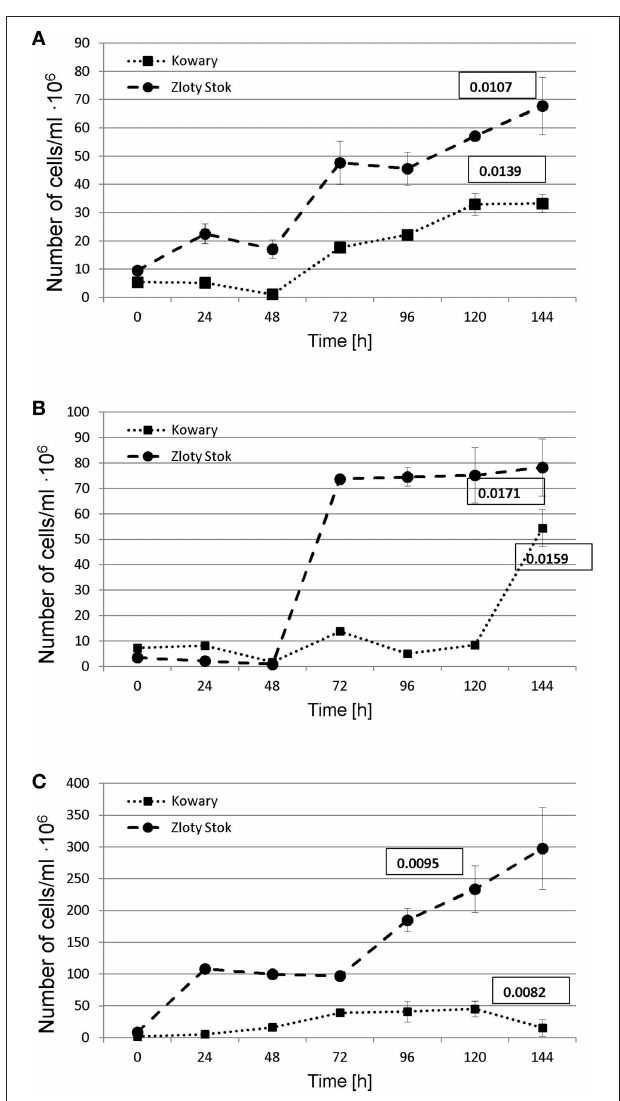
FIGURE 7 | Growth of dissimilatory arsenate (A), sulphate (B), and iron (Fe III) (C) reducers under anaerobic conditions on minimal salt medium supplemented with 5 mM sodium lactate and 2.5 mM of proper salt of electron acceptor (AsO 3 − 4 , SO 2 − 4 , or Fe 3 + ). Growth rates (number of doublings that occur per hour) are shown in the